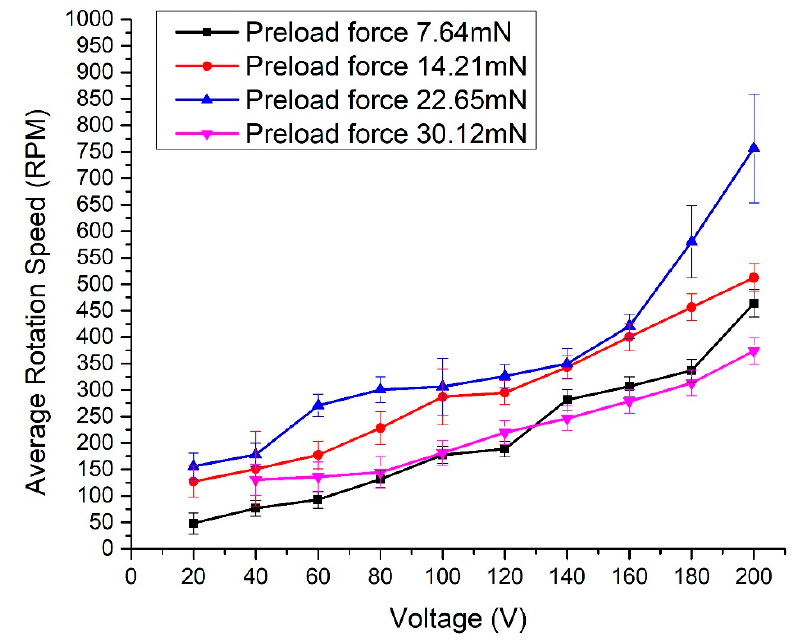
ff erent excitation voltages and preload Figure 13. The average rotation speed at different excitation voltages and preload forces. Figure 13. The average rotation speed at di